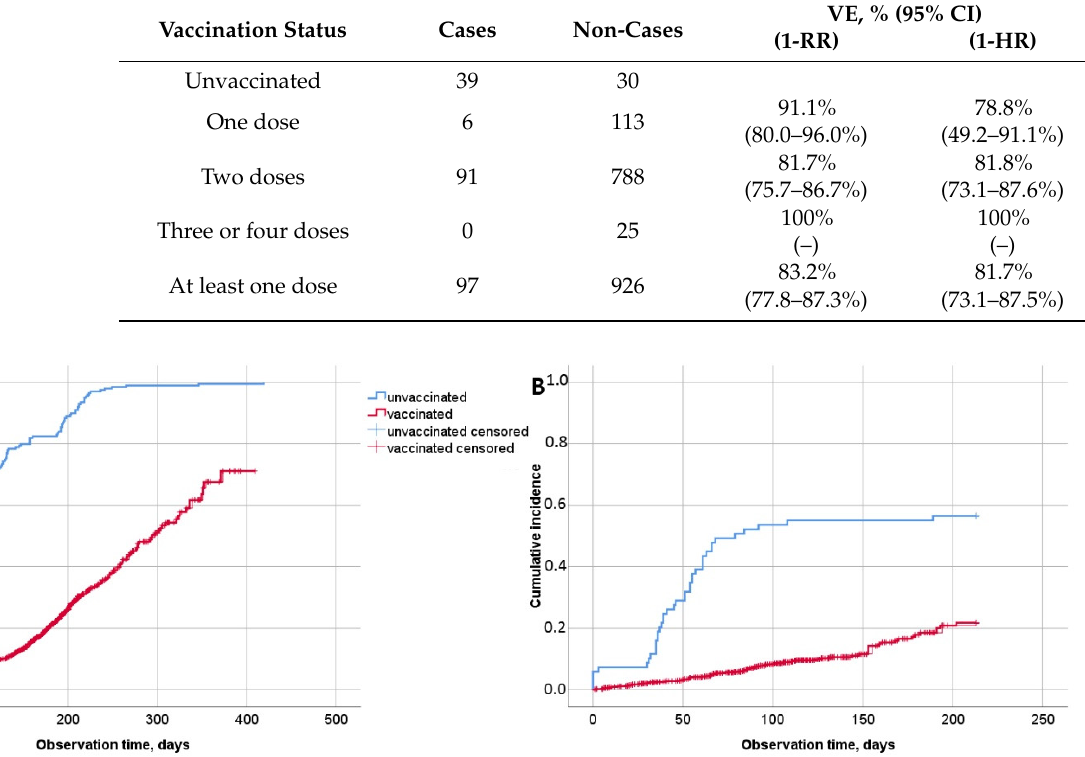
Figure 3. The cumulative risk of medical center employees, depending on the availability of vaccination. ( A ) For the entire period, HR = 0.109 (95% CI: 0.090–0.131), which corresponds to VE = 89.1% (95% CI: 86.9–91.0%); ( B ) for the Delta dominance period, HR = 0.167 (95% CI: 0.113–0.245), which corresponds to VE = 83.3% (95% CI: 75.5–88.7%).